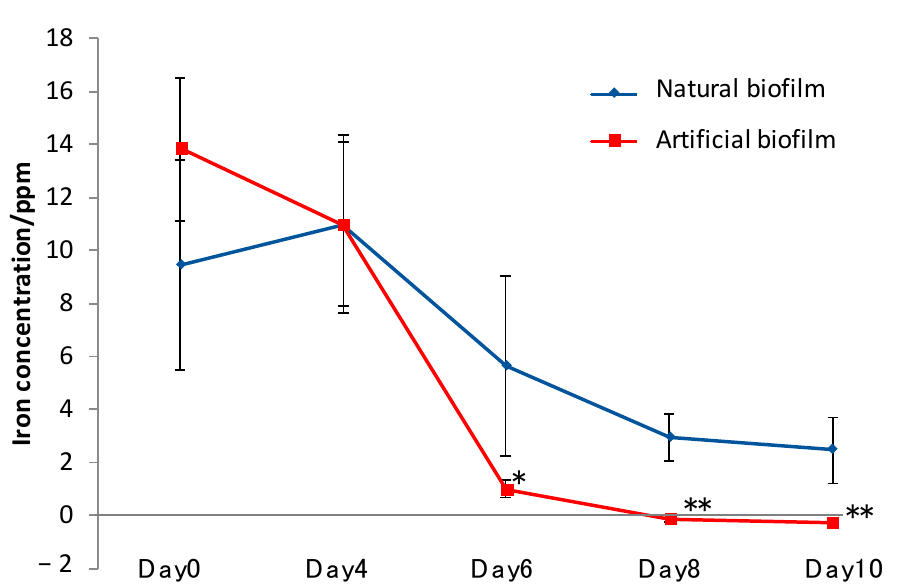
Figure 9. Iron concentrations eluted in medium (day 0) and seawater (day 4, 6, 8, 10) in the presence of biofilm. After day 4, the medium was changed to natural seawater. There were no significant differences in the concentrations between artificial and natural biofilms. After day 6, iron elution was largely decreased in the condition using artificial biofilm as compared to the natural biofilm. (Means ± SD, n = 6) ( t -test, * p < 0.05, ** p < 0.01).